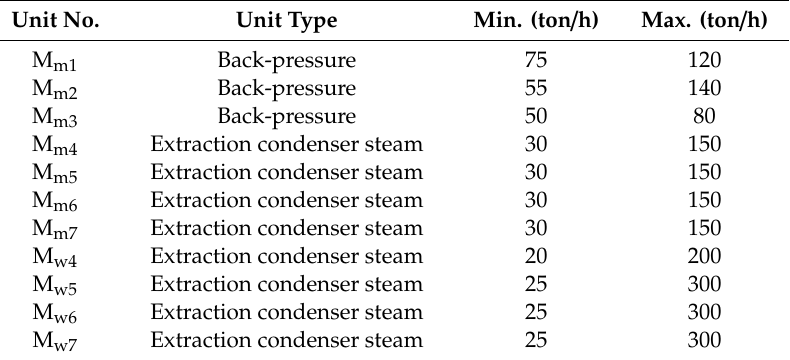
Table 3. Steam output limits.